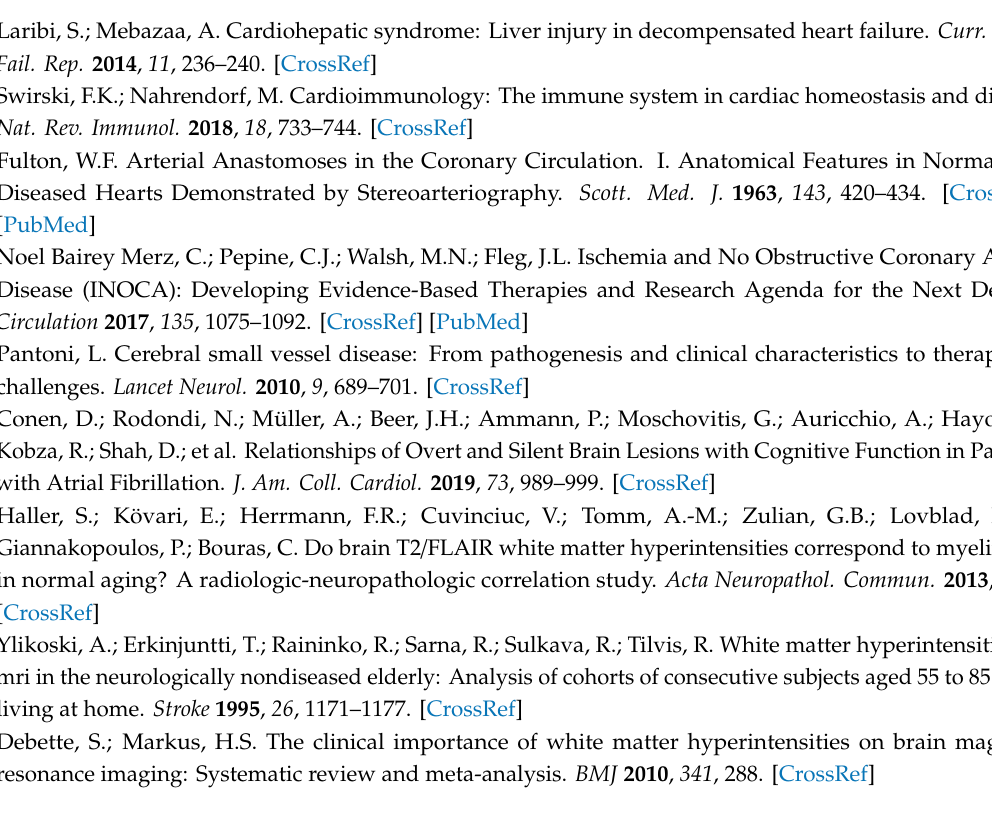
Table S1: Results of univariable and multivariable ordered logistic regression analysis for predicting higher numbers of subcortical white matter lesions, Table S2: Results of univariable and multivariable ordered logistic regression analysis for predicting higher numbers of deep white matter lesions, Table S3: Results of univariable and multivariable ordered logistic regression analysis for predicting higher numbers of periventricular white matter